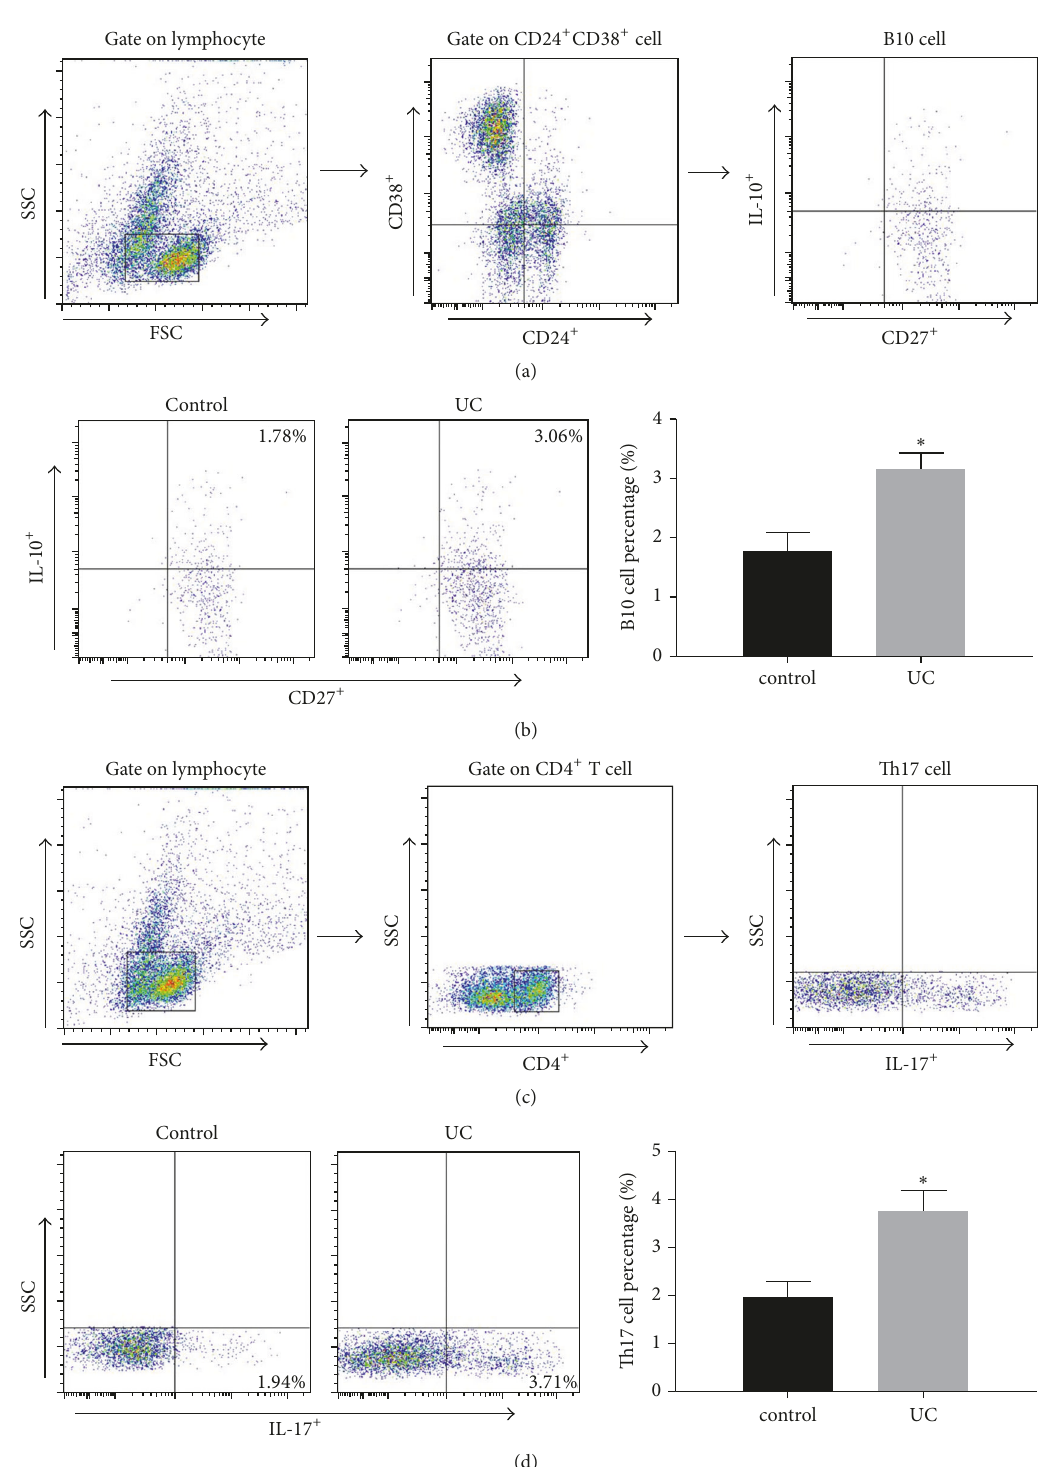
Figure 2: B10 cell and Th17 cell counts in ulcerative colitis patients and healthy subjects. (a-b) Gating criteria to define the CD24 + CD27 + CD38 + IL-10 + Breg cell population. Different cell subsets were distinguished according to different cell labels. (c-d) The percentage of CD4 + IL-17 + cells in peripheral blood. Compared with control group, ∗ 𝑃 < 0.05